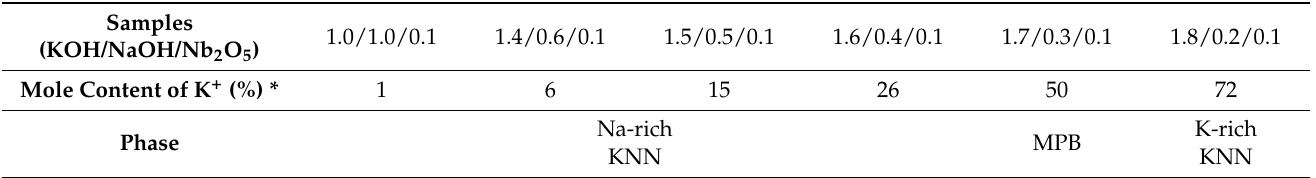
Figure 11. EDS analysis of KNN particles synthesized in glycothermal conditions with molar ratio of K + /Na + to 1.7/0.3 at 200 °C for 12 h. Table 3. The calculated EDS results of each K + content of KNN particles obtained in glycothermal conditions with varying molar ratios of K + /Na + at 200 °C for 12 h.